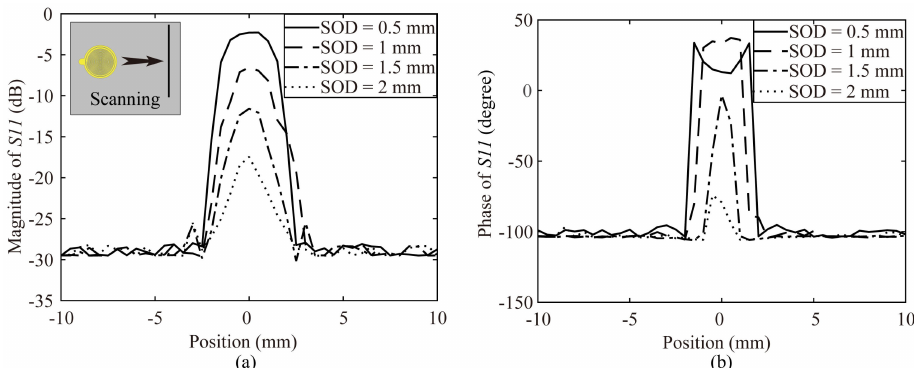
Figure 7. ( a ) The simulated magnitude variation of the reflection coe ffi cient for the proposed probe scanning a conducting wire with di ff erent SODs; ( b ) The simulated phase variation of the reflection coe ffi cient for the proposed probe scanning a conducting wire with di ff erent SODs.